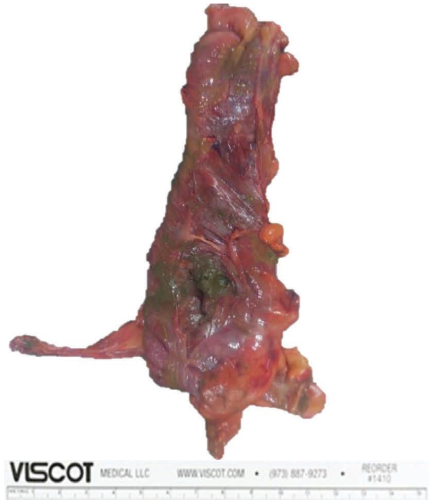
Figure 4: Gross specimen. Description: upon opening the peri- toneum, free air was evacuated. Approximately 1.4L of fecaloid peritoneal fuid was suctioned. Adhesive band noted at the pelvic area. Noted a 2cm full thickness perforation at the cecum. 17 cm serosal tear from the cecum to ascending colon. Bowel loops proximal to the perforation were dilated.